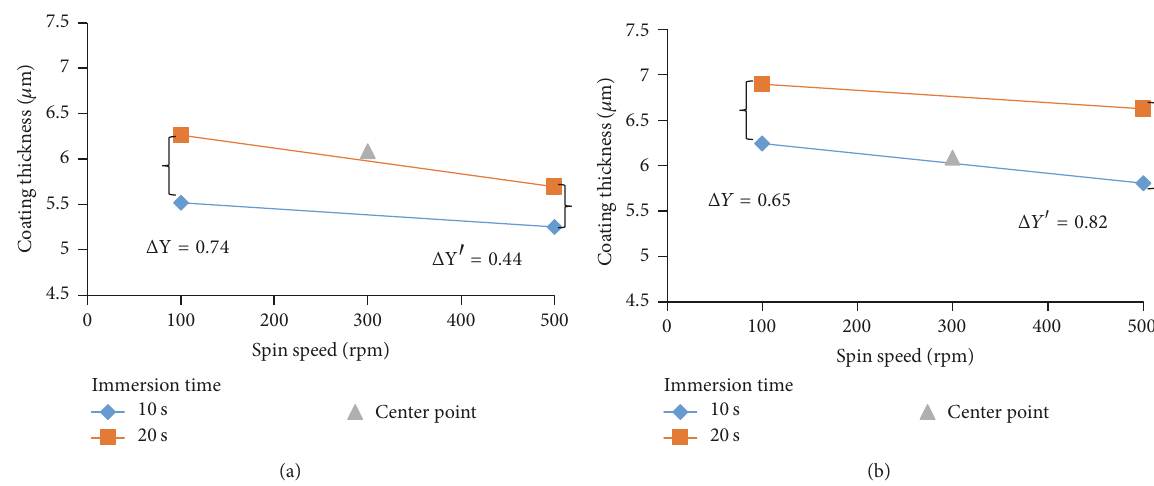
Figure 7: Interaction effect plots of spin speed and immersion time at (a) withdrawal rate of 20mm/s and (b) withdrawal rate of 25 mm/s.